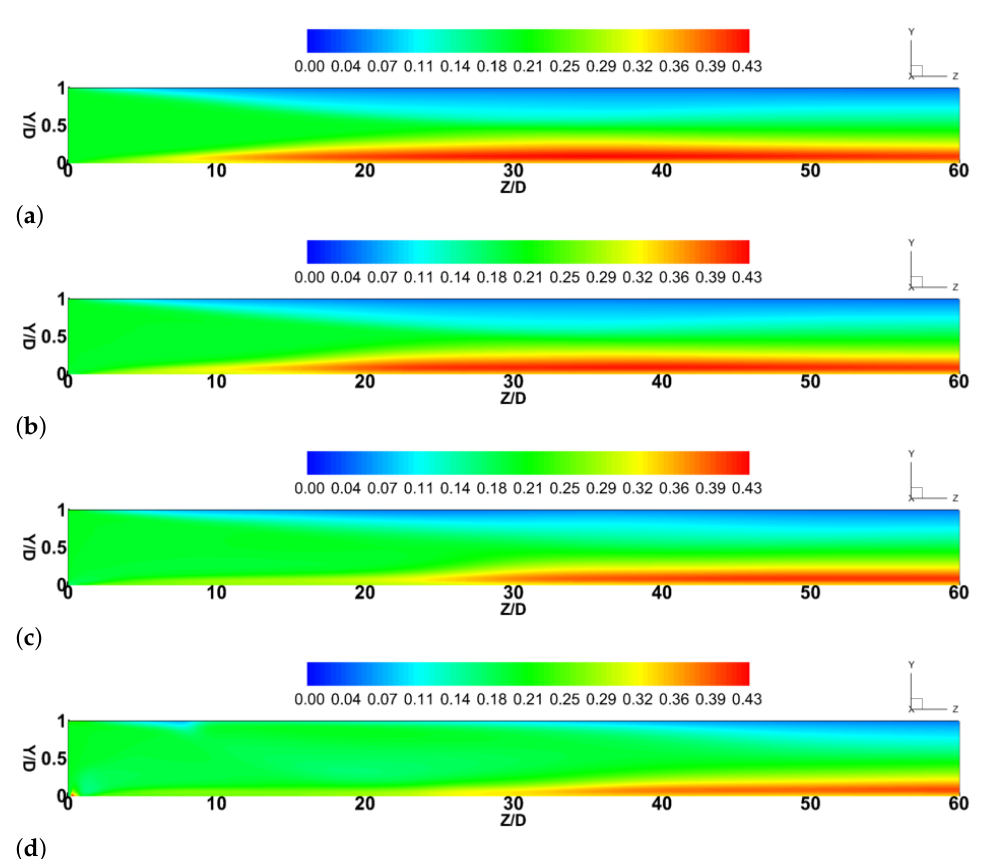
Figure 4. Contours of mixture solid volume fraction in the middle plane: ( a ) SR = 0; ( b ) SR = 0.1; ( c ) SR = 0.25; ( d ) SR =